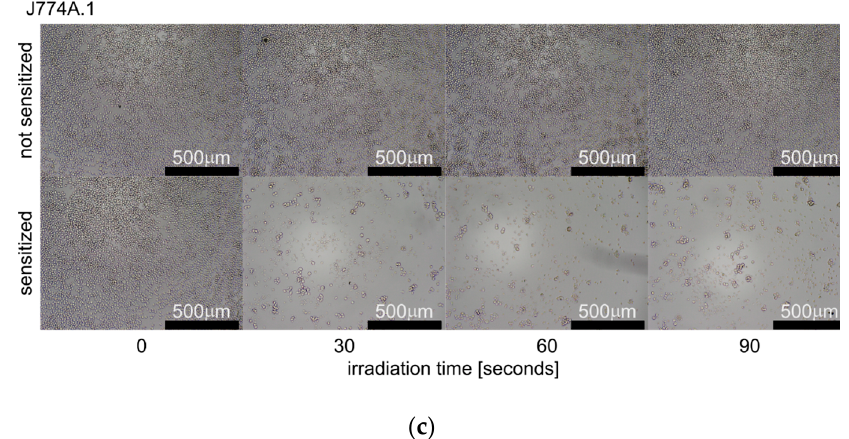
Figure 7. Assessment of in vitro photodynamic treatment (PDT). ( a ) The cells were pre-incubated for 30 min with liposomal formulation of Photolon and irradiated with a 655 nm diode laser for the indicated time. The viability of the cell cultures was assayed using a MTS assay. Results are expressed as a percentage of untreated control. Average ± SD are shown. ( b ) Irradiation-induced reactive oxygen species (ROS) assayed with a fluorescent H 2 DCFDA probe. Average RLU ± SD are shown. ( c ) Morphology and density of irradiated J774A.1 cell cultures subjected to photosensitization.